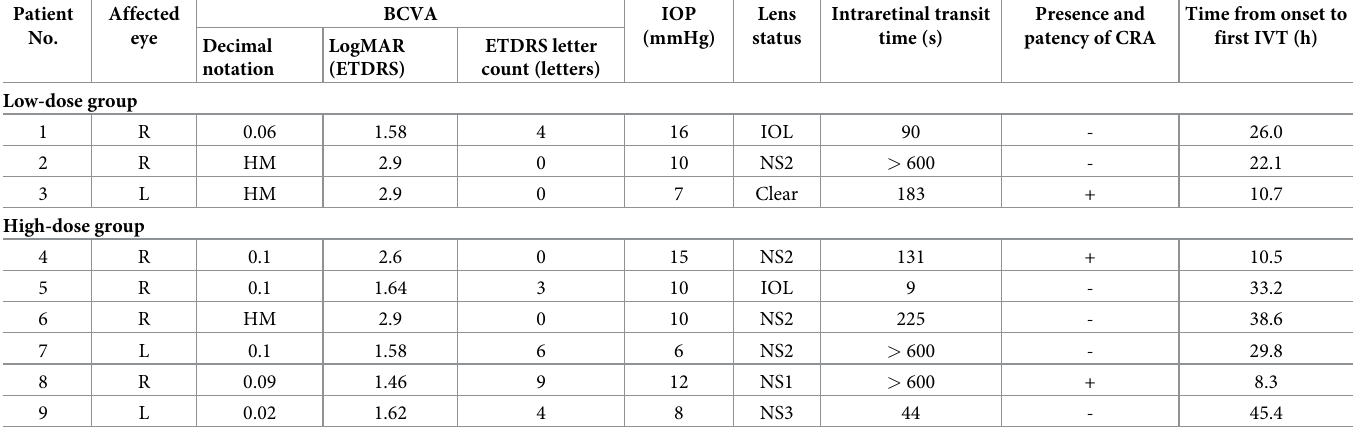
neovascularization was eliminated after pan-retinal photocoagulation. Side effects that were undeniably associated with KUS121 are listed in Table 3. Plasma concentrations of KUS121 reached maximum levels 2 h after intravitreal injections, except on day 3 in the low-dose group. Maximal concentration of KUS121 (C was 0.0721 ± 0.012 ng/mL in the low-dose group and 0.166 ± 0.106 ng/mL in the high-dose group (Tables 4 and 5). The concentrations decreased to sub-detection level 24 h after injec- tion (immediately before the second injection). The plasma concentrations of KUS121 on days 2 and 3 were similar to that on day 1. Table 2. Baseline characteristics of the objective eyes. Patient Affected No. eye